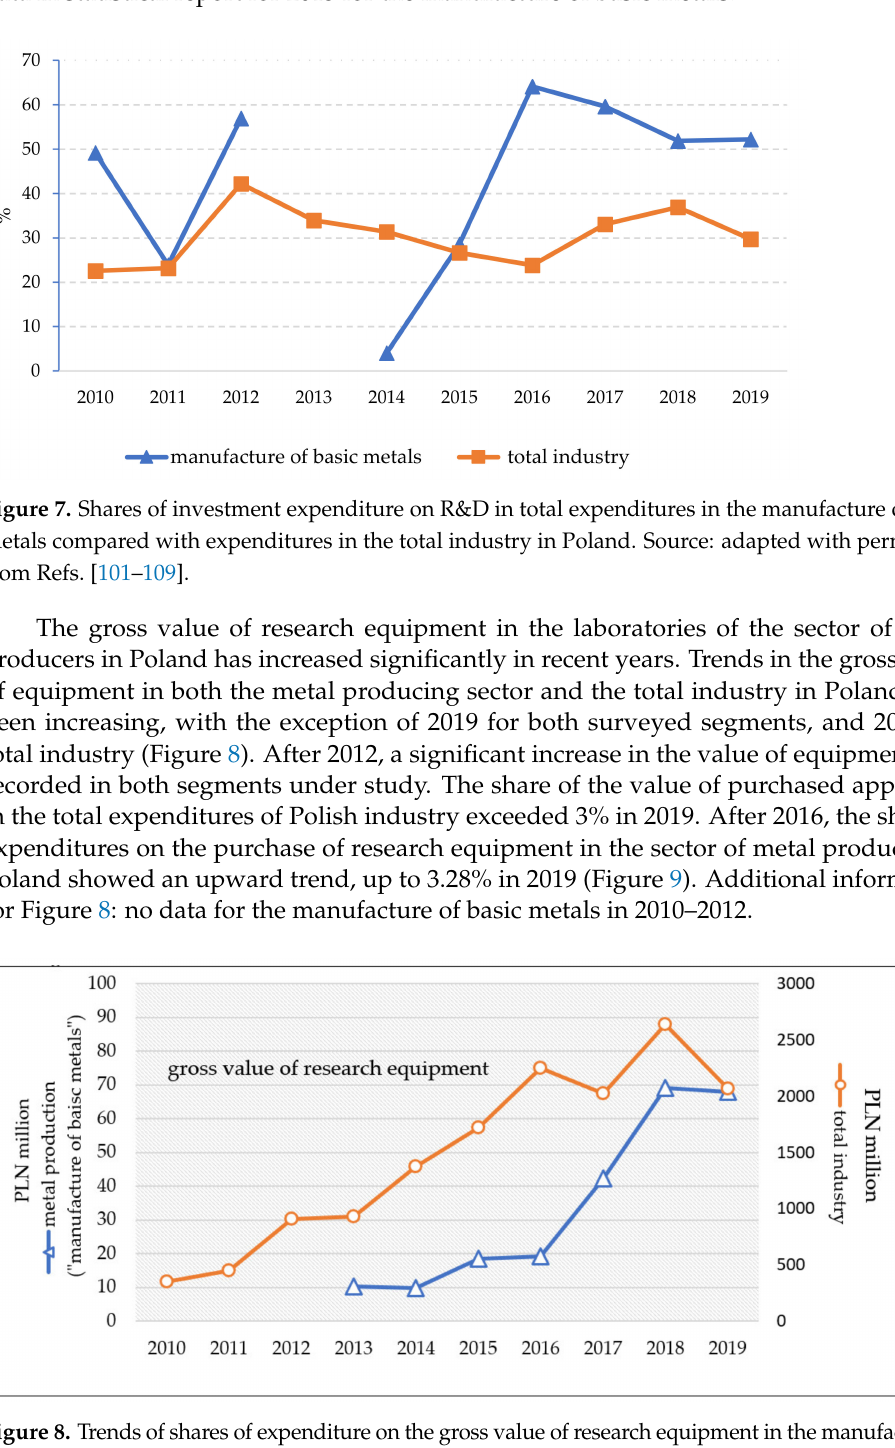
Figure 8. Trends of shares of expenditure on the gross value of research equipment in the manufacture of basic metals and in the total industry in Poland. Source: adapted with permission from Refs.